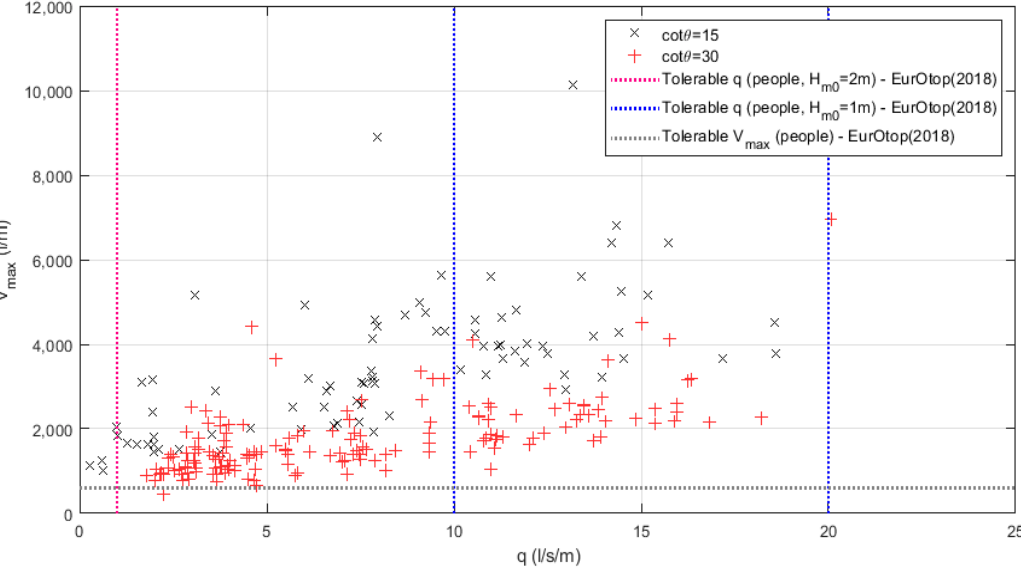
Figure 10. Variation of maximum individual overtopping volume with mean discharge (dimensions in prototype). Limits for safety of pedestrians and assets based on EurOtop (2018) are shown. The two vertical blue lines correspond to tolerable discharges of 10 L/s/m and 20 L/s/m respectively, for H m0 = 1 m.